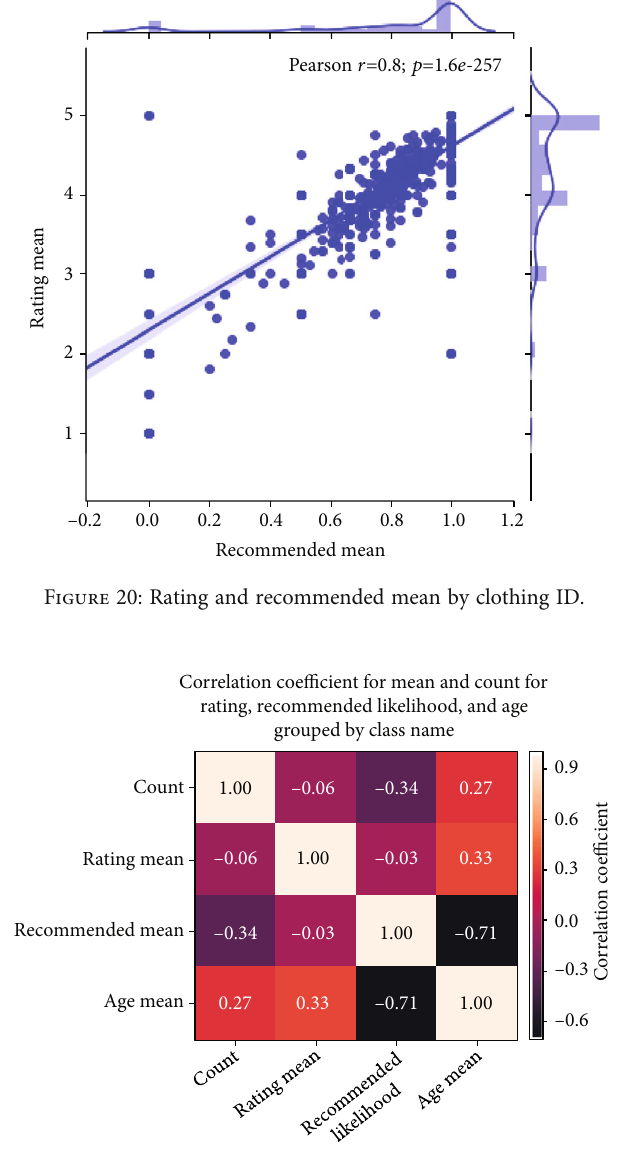
Figure 21: Good correlations between both the average age and the probability of recommendation in di ff erent class groups.